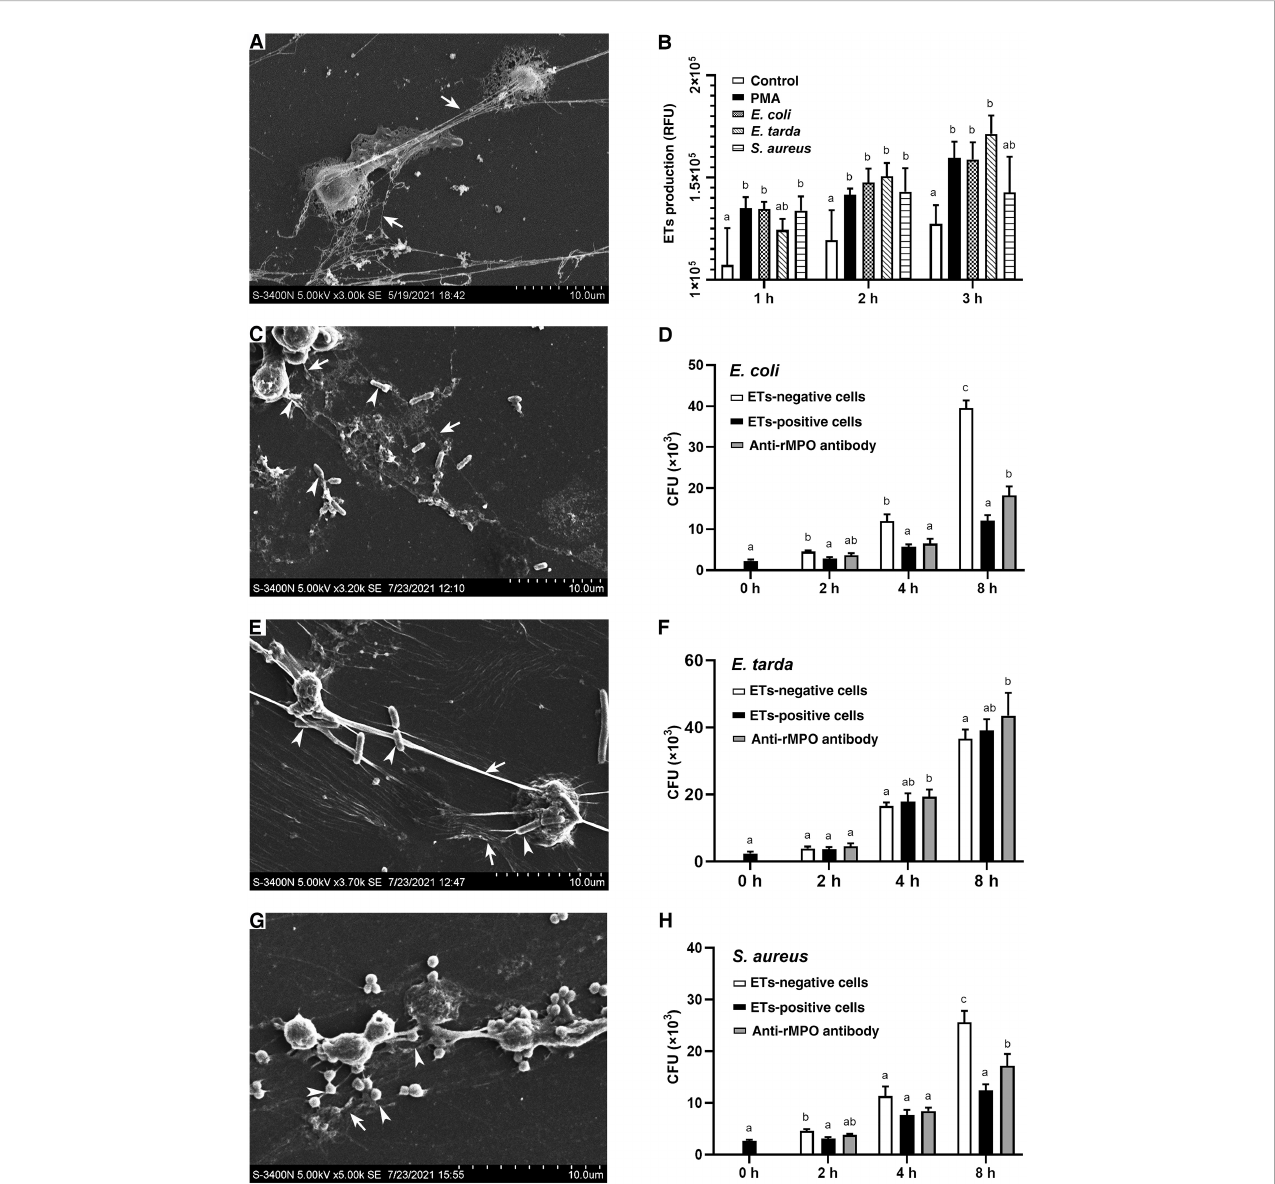
FIGURE 7 SEM analysis of the entrapment of bacteria by ETs and the proliferation of the entrapped bacteria. (A) PMA-induced production of ETs. (B) The quantitative analysis of the formation of ETs by leukocytes in response to PMA, E. coli , E. tarda , and S. aureus for 3 hours. (C, E, G) show E. coli, E. tarda , and S. aureus induced the ET formation (arrows with tail) and entrapped bacteria (arrows without tail), respectively. (D, F, H) show the effect of Po MPO on the antimicrobial activity of ETs. ETs-producing cells were incubated with E. coli , E. tarda, or S. aureus in the presence or absence of anti- Po MPO Abs. Bacterial survival was determined at various time points. Different letters above the bar represent the statistical signi fi cance compared to each other at the same time point, and vertical bars represented the mean ± SD, n = 5 ( P <